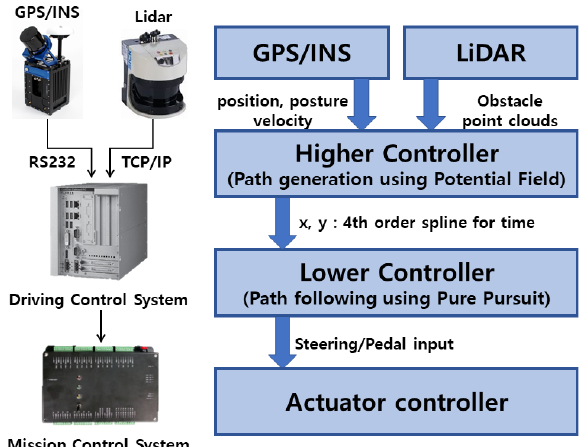
Figure 3. Flow chart of autonomous driving algorithm.